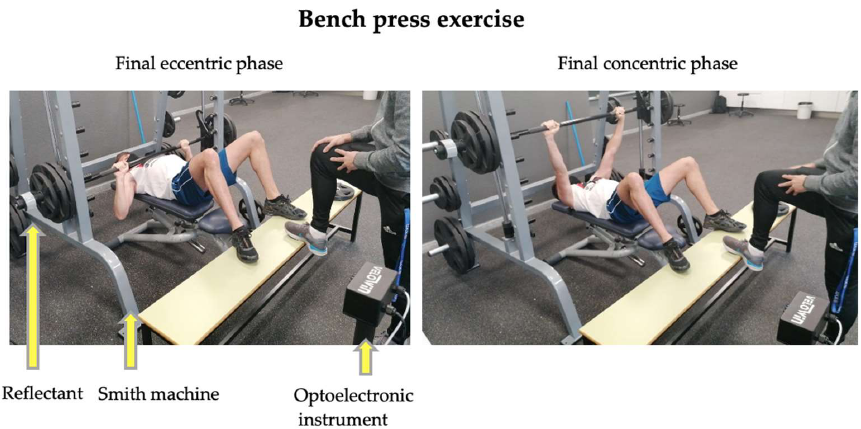
Figure 2. Bench press exercise performed by one of the study